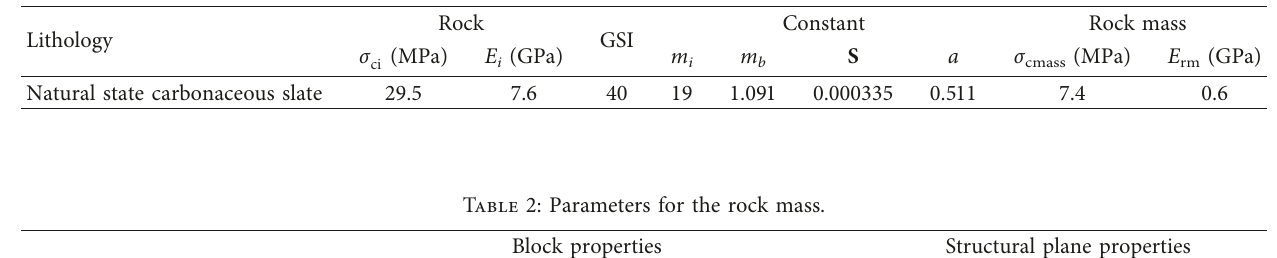
Figure 14: Anchor cable arrangement in the tunnel. (a) Anchor cable and surrounding rock. (b) Anchor cable and lining. Table 1: Rock properties and rock mass properties.